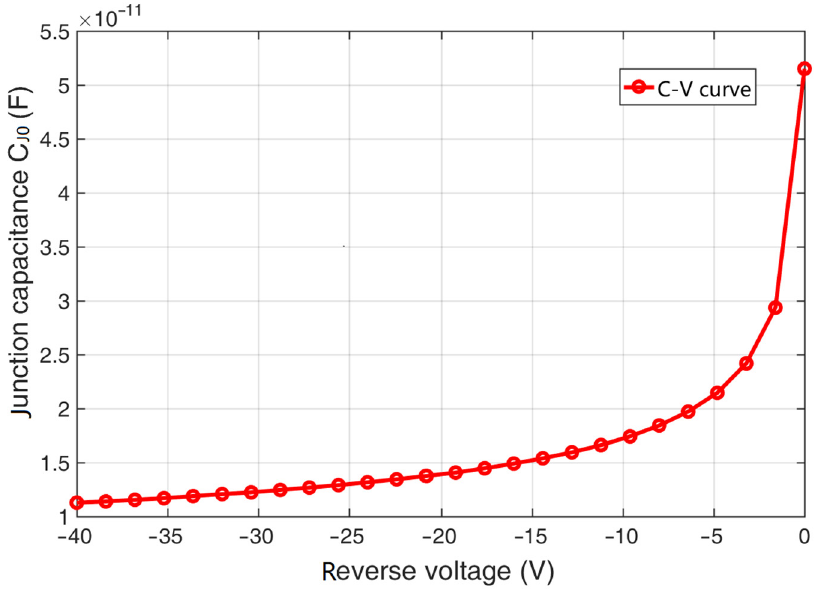
Figure 11. The junction capacitance test result.